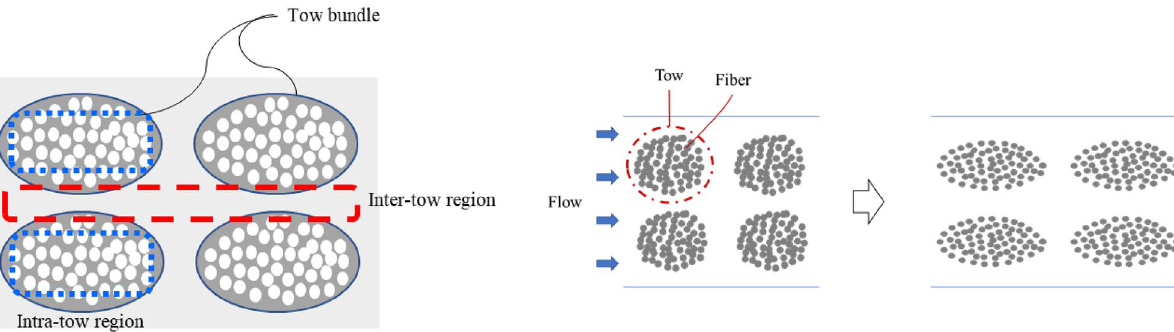
Figure 8. Inter-tow region and intra-tow region (left), tow behavior with flow in the double-scale porous media